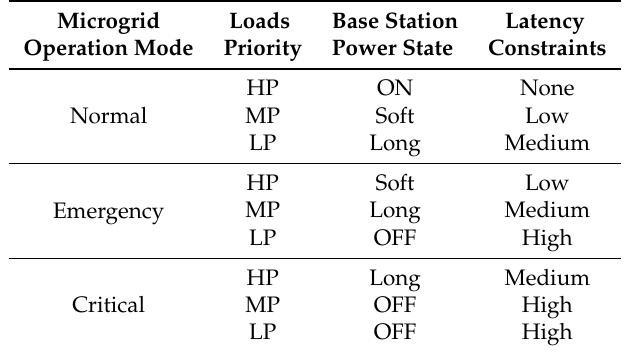
Table 3. Energy saving communication scheme for islanded operation.